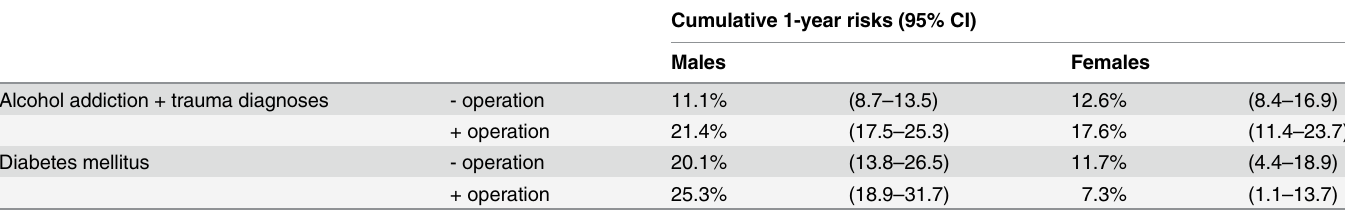
Table 4. Cumulative 1-year risks of recurrent SDH, according to selected combinations of predictive